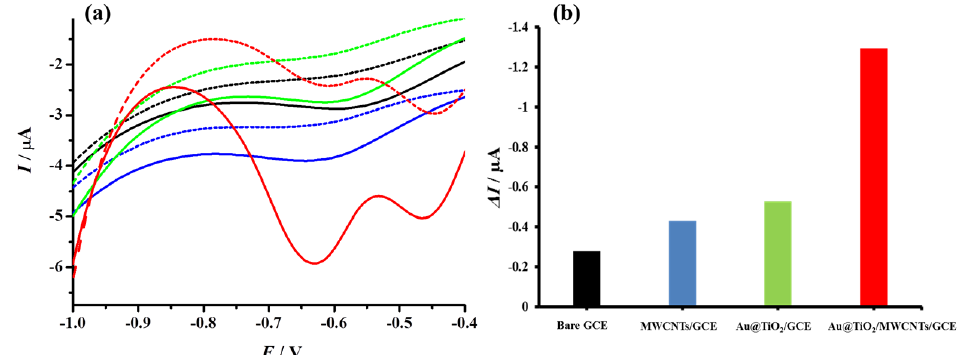
Figure 10. ( a ) Differential pulse voltammograms recorded in PBS (dashed lines) and 300 µM H 2 O 2 (solid lines) for various stages of electrode modification, Bare GCE (black); MWCNTs/GCE (blue); Au@TiO 2 /GCE (green); Au@TiO 2 /MWCNTs/GCE (red). ( b ) Histogram represents the corresponding change in current values ( ΔI ).